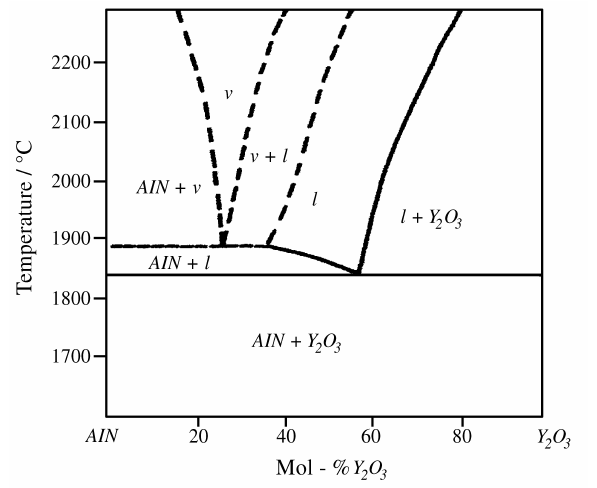
Figure 1. Behavioral diagram of the AlN-Y 2 O 3